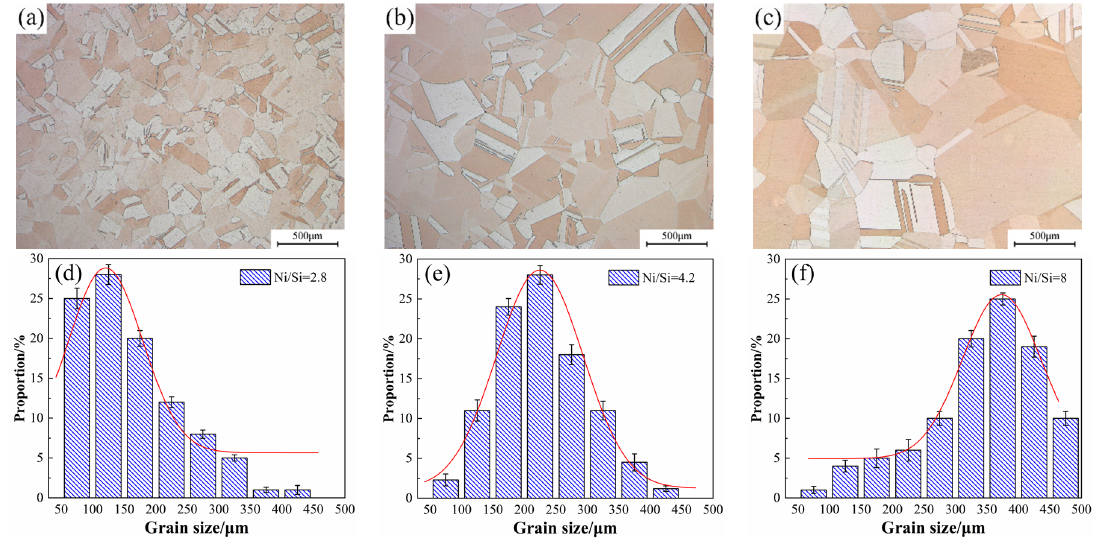
Figure 6. Average grain size of alloys with different Ni/Si mass ratios aged at 500 °C for 2 h; ( a , d ) NS ‐ 1, ( b , e ) NS ‐ 4, and ( c , f ) NS ‐ 9.